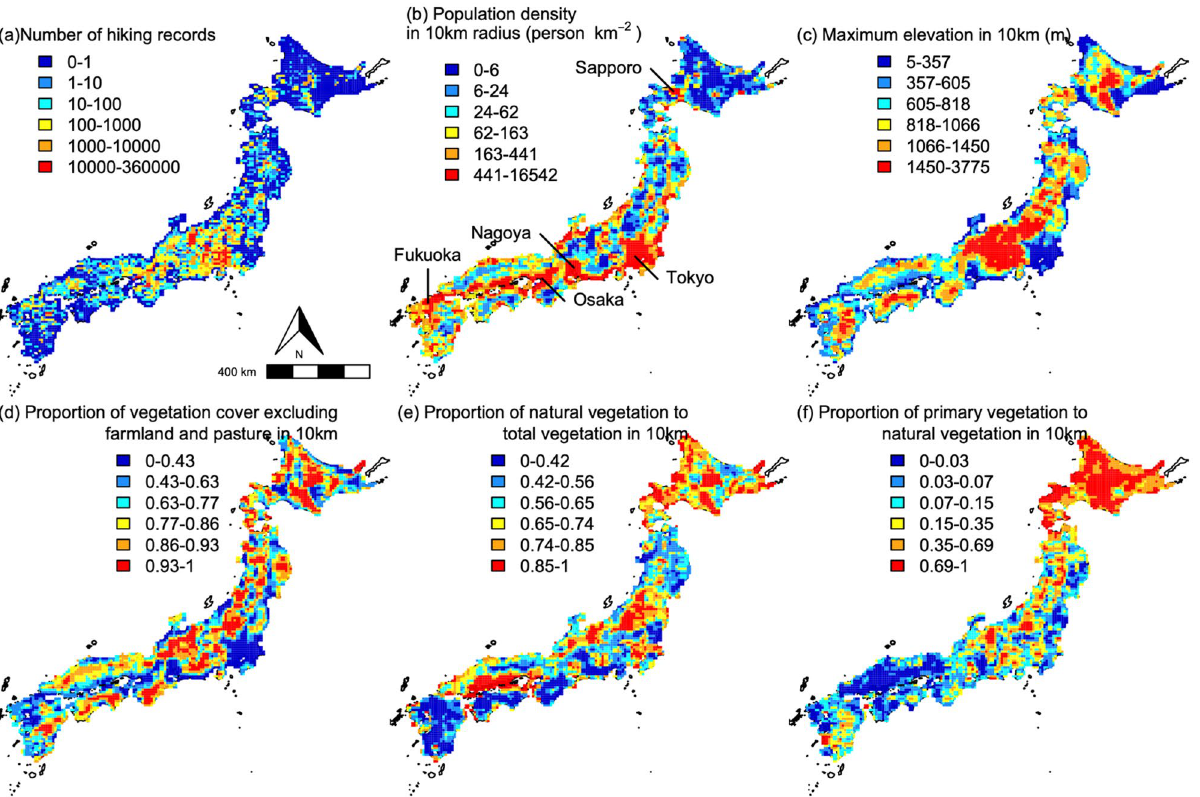
Figure 1. Maps of important variables in the study area summarized for the standard grids. ( a ) Number of hiking records, ( b ) population density in 10 km radius from the center of each grid with some big cities, ( c ) maximum altitude in 10 km, ( d ) total vegetation cover in 10 km, ( e ) proportion of natural vegetation to total vegetation cover in 10 km, ( f ) proportion of primary vegetation to natural vegetation in 10 km. The maps were drawn using R 4.1.1 software package 29 with public data of the border (https:// www. gsi. go. jp/ kanky ochiri/ gm_ jpn.